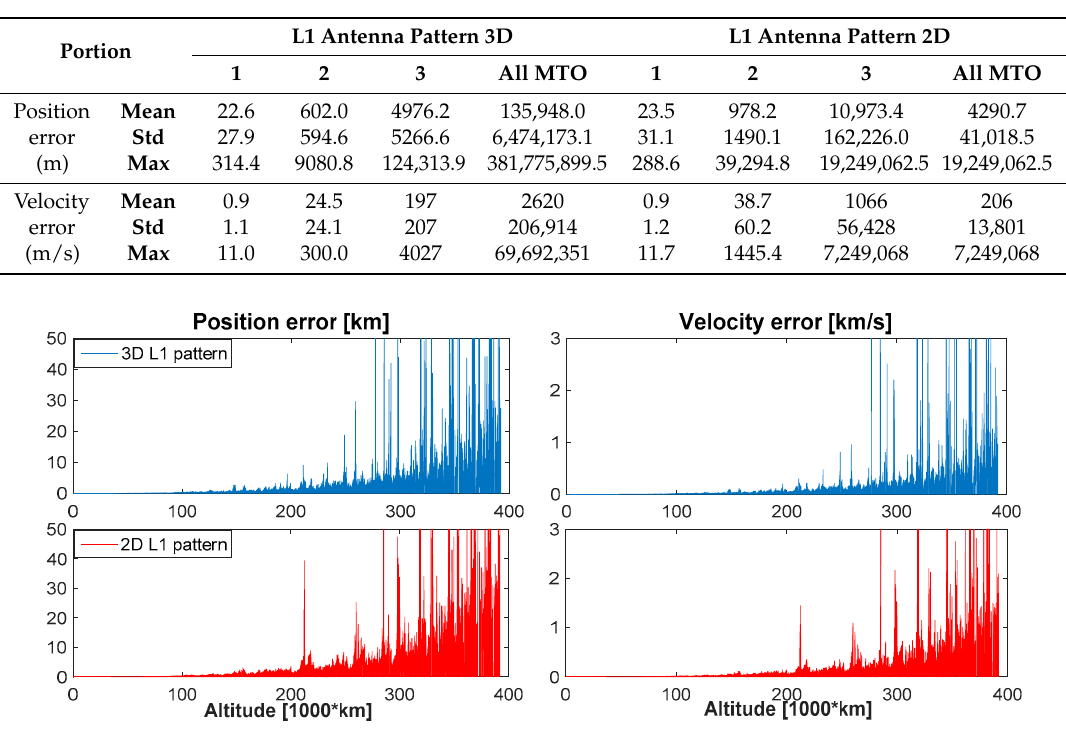
Figure 17. Single-point least squares estimation error for the assumed MTO. Table 4. Statistics of the single-point least squares estimation error.